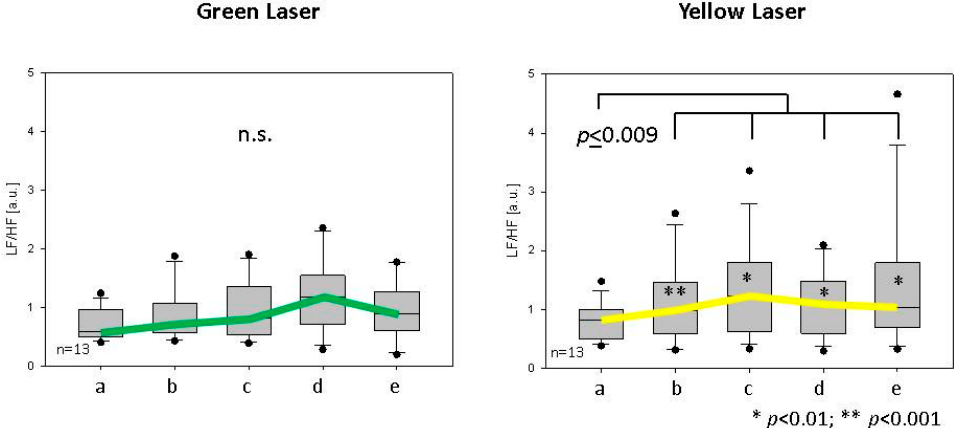
Figure 5. Heart rate variability: low frequency (LF)/high frequency (HF) ratio in women after green and yellow laser stimulation. Note the significant increase during (b–d) and after (e) Shenmen (ear point) irradiation with yellow laser light. For further explanations see also Figures 3 and 4.